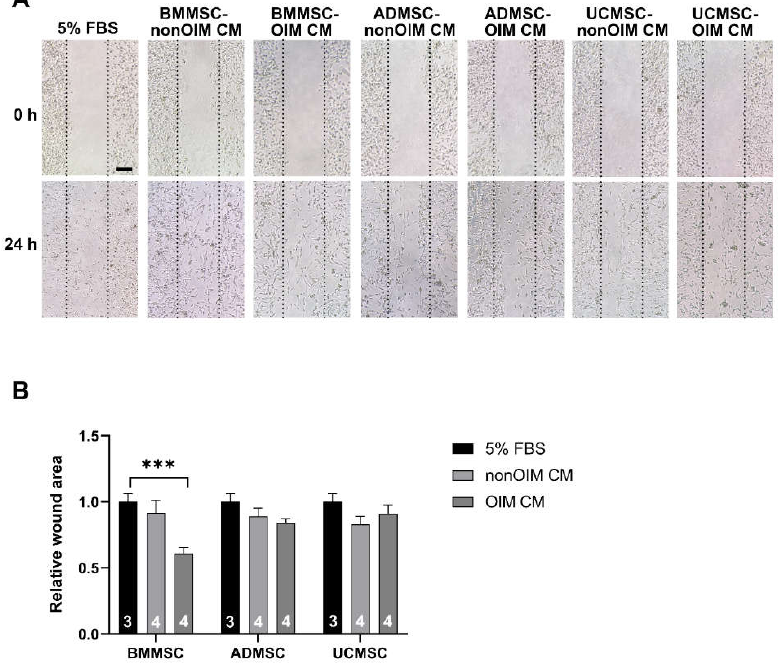
Figure 2. Cell migration was analyzed by wound healing assay using HUVEC cells. ( A ) Representa- tive images showed the results of cell migration at 0 h and 24 h. ( B ) The wound closure of each group was normalized with the 5% FBS group and expressed as a relative wound area. Data were analyzed using a one-way ANOVA with Tukey’s post hoc test to determine statistical significance. Bar graphs present mean ± SEM. The number of replicates is inside the bars. The scale bar is 100 mm. Statistical significance is present as *** p < 0.001 (compared to 5% FBS) and the results do not reach the statistical differences that are not